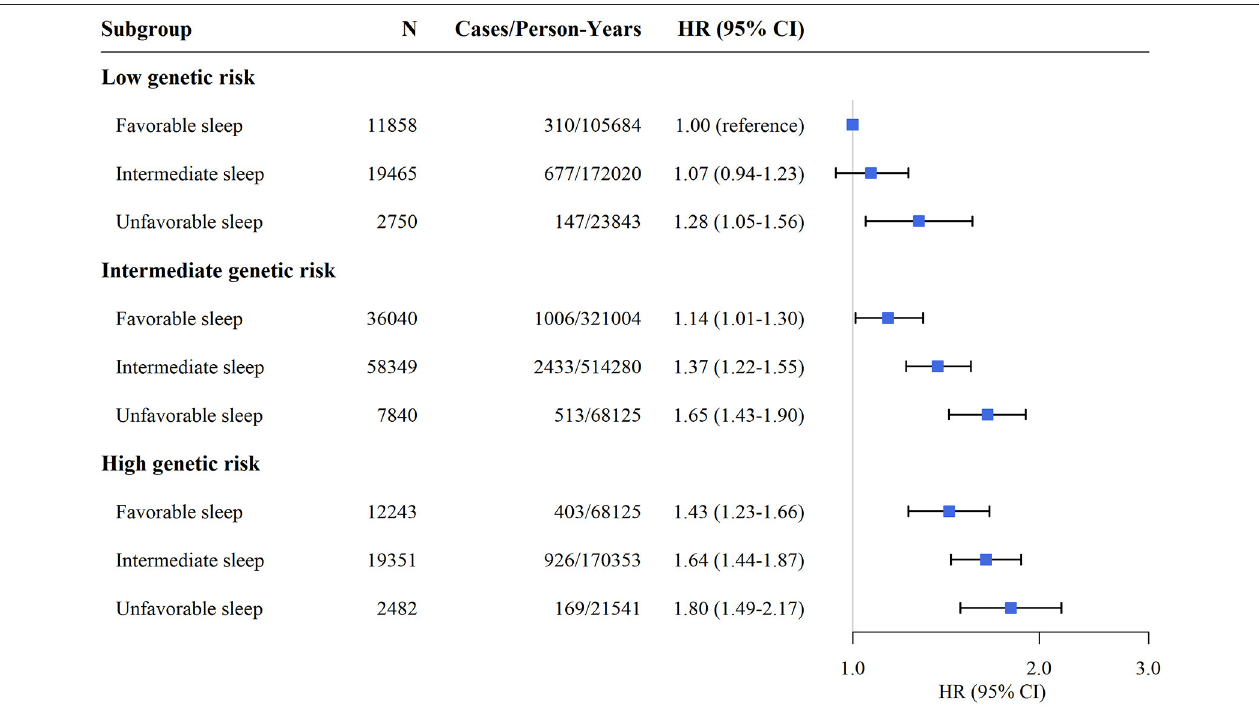
FIGURE 1 | Risk of incident hypertension according to sleep pattern and genetic risk. CI, confidence interval; HR, hazard ratio. The results were obtained after adjusting for age, sex, education, TDI, race, physical activity level, smoking status, alcohol consumption, family history of hypertension, body mass index, depression, cancer, and